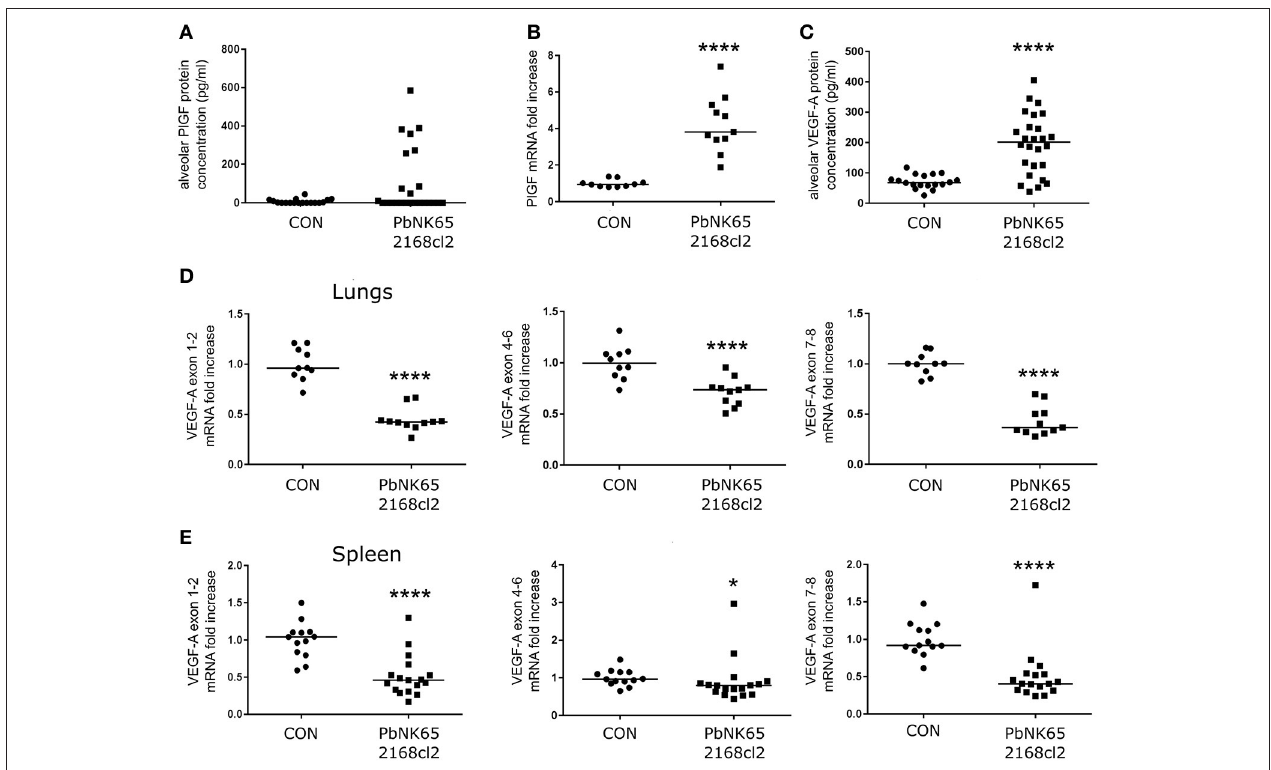
FIGURE 2 | PlGF and VEGF-A are increased in lungs of mice with MA-ARDS. Mice infected with PbNK65 2168cl2 were dissected at day 7 pi. (A) Protein levels of PlGF were determined in BALF. (B) The mRNA expression levels of PlGF were measured in total lung extracts. (C) Protein levels of VEGF-A were determined in BALF. (D,E) The mRNA levels of different splice variants of VEGF-A were determined in extracts of lungs and spleen. (B,D) Two experiments, (E) three experiments, (A) four experiments, and (C) five experiments, n = 10–27 per group.